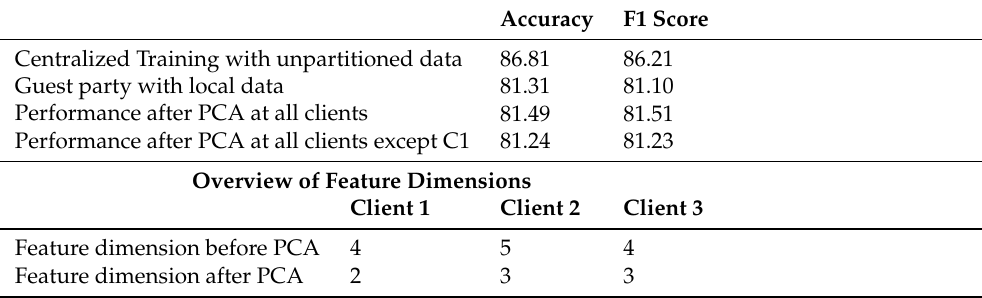
Table 3. Experimental Results on Heart Disease Prediction